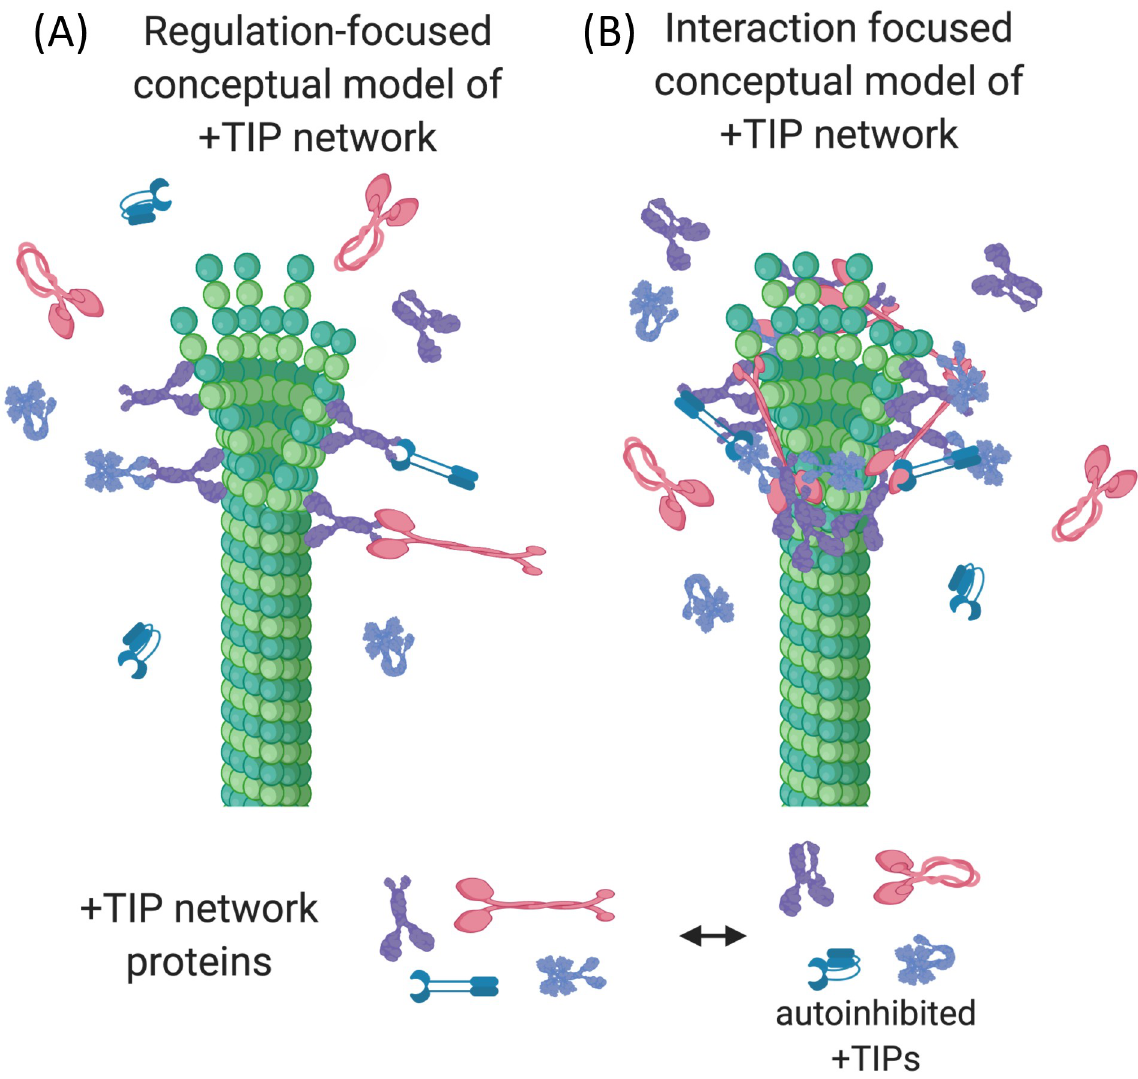
Fig 1. Conceptual models of the +TIP network. (A) In the regulation-focused model of the +TIP network, interactions between +TIPs function primarily to activate autoinhibited +TIP proteins and/or enable +TIPs to localize to the plus end. (B) In a more physical model of the +TIP network, interactions between +TIP proteins form a cross-linked, dynamic scaffold that supports and stabilizes the fluctuating MT tips by promoting lateral binding of protofilaments [4]. This figure was created with BioRender [5].